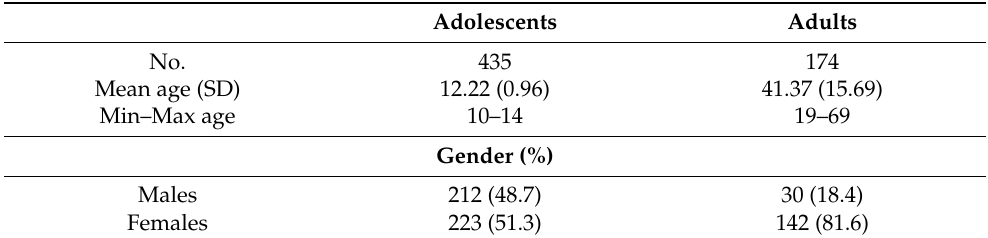
Table 1. Demographic characteristics of the adolescent and adult population recruited for the validation of the ARI and BSIS